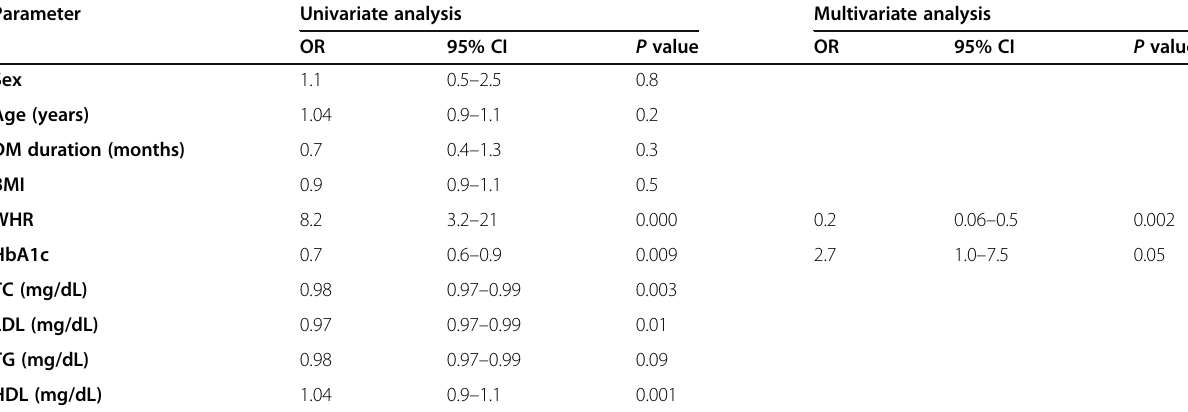
Table 4 Univariable and multivariable logistic regression analysis for prediction of diastolic dysfunction Parameter Univariate